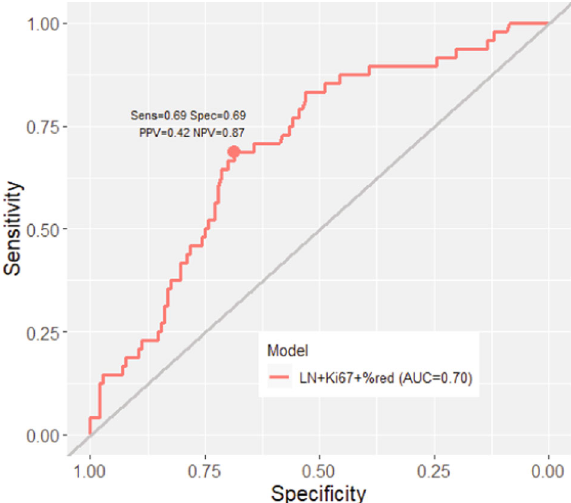
Fig. 4 A logistic regression model predictive of PDX engraftment success. The ROC curve is shown for the logistic regression model. The model includes patient ’ s LN status at diagnosis, % Ki67 positive cells at diagnosis, and mid-NACT tumor volumetric reduction as evaluated by ultrasound.